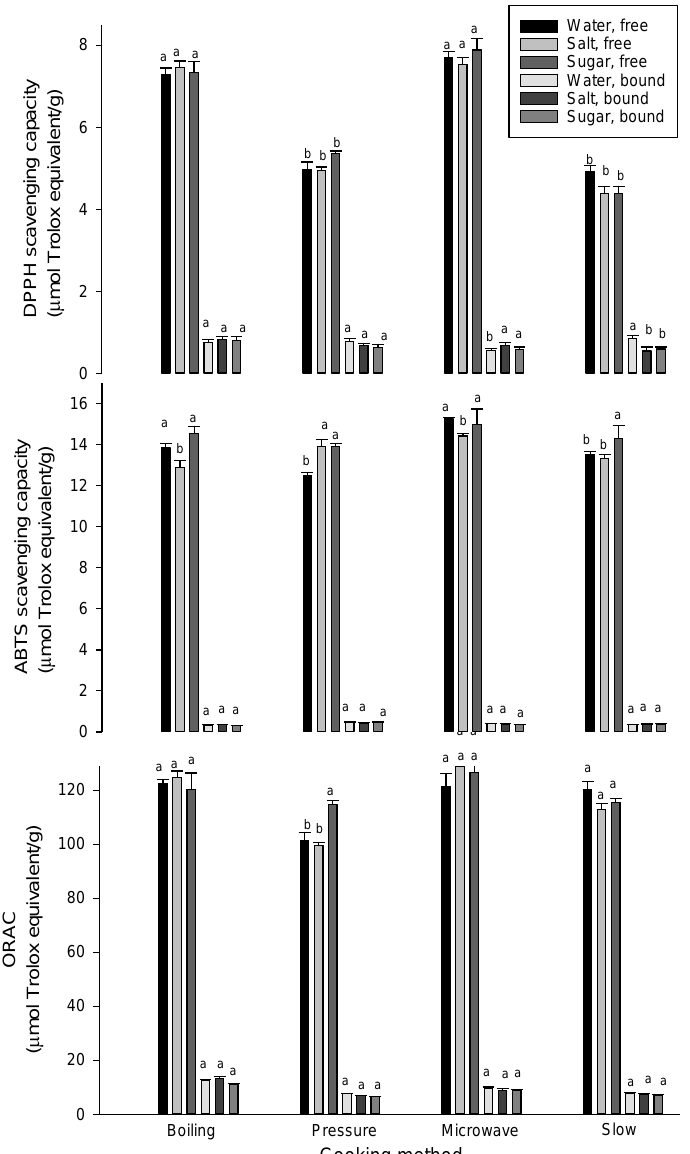
Figure 1. Antioxidant capacities of free and bound phenolic extracts of faba beans (µmol trolox equivalent / g, db) measured by DPPH (top), ABTS (middle) and Oxygen Radical Absorbance Capacity (ORAC) (bottom) assays. For free or bound phenolic extract, means followed by a different letter are significantly different at p < 0.05. Error bars represent standard deviation values ( n = 3).